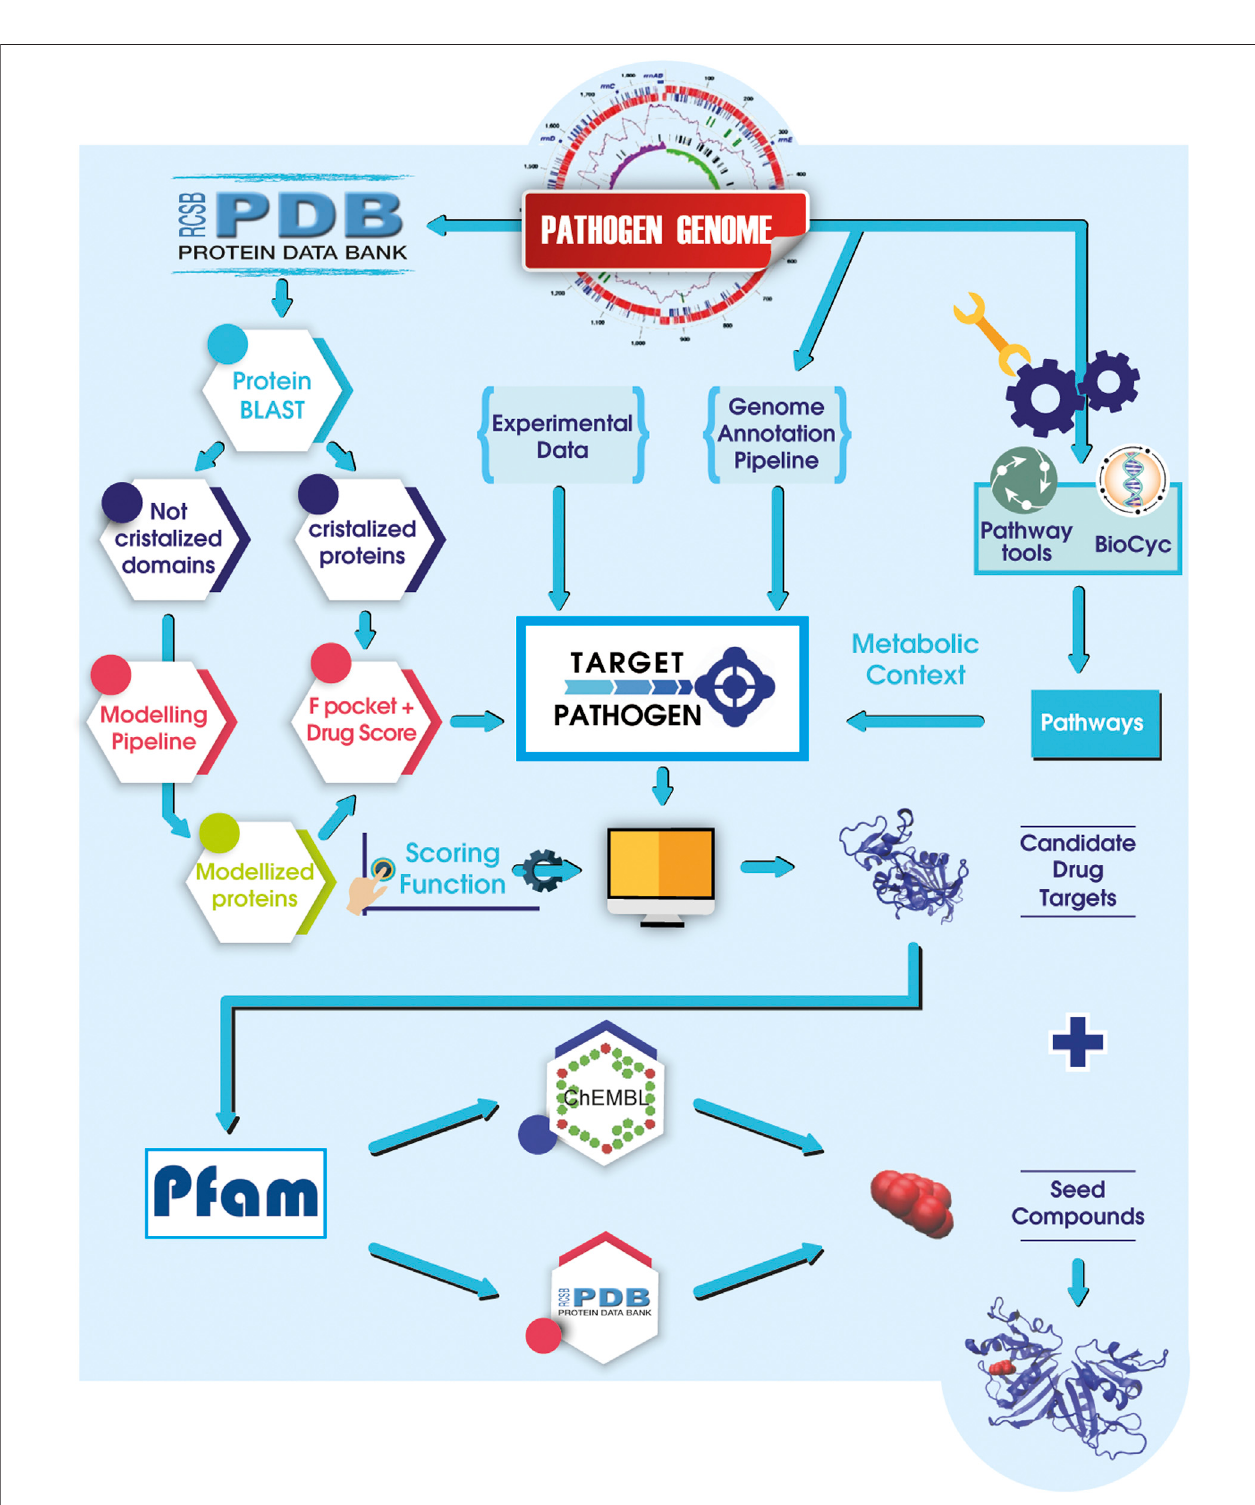
FIGURE 1 | A general sketch of Target-Pathogen integrated with LigQ pipeline. Structural druggability and metabolic analyses are integrated with available experimental data and in silico analysis data. After all, data is integrated into Target-Pathogen, a user-designed scoring function is used to weight different features to obtain a ranked list of candidate drug targets. Once the target is selected, LigQ pipeline fi nds all known binders of similar proteins in the PDB and ChEMBL. Target and putative binders can be used in further molecular docking assays.